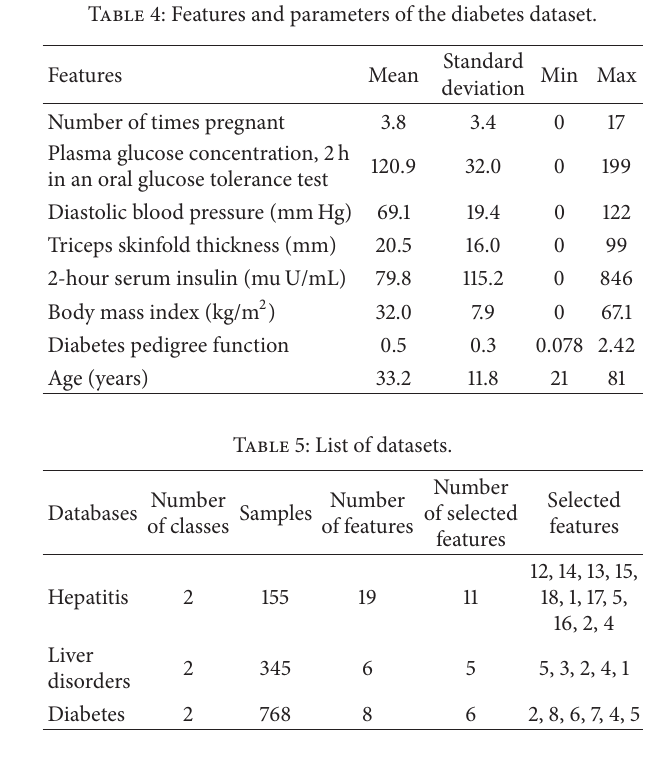
Table 6: List of classification parameters.